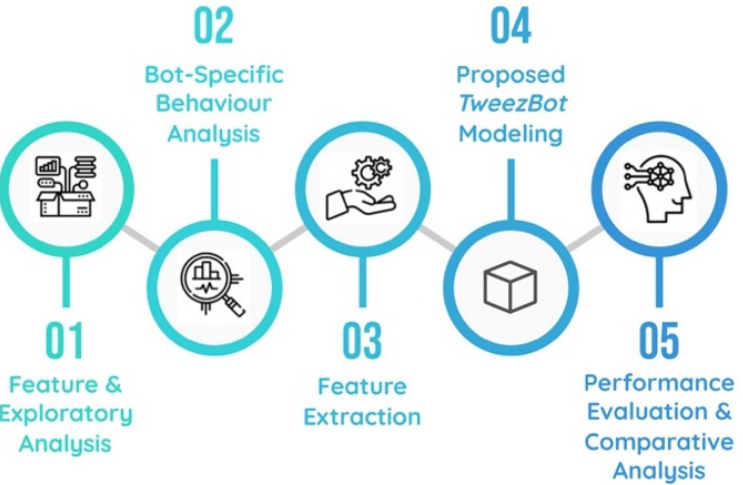
Figure 1. Infographic depicting our model flow diagram .